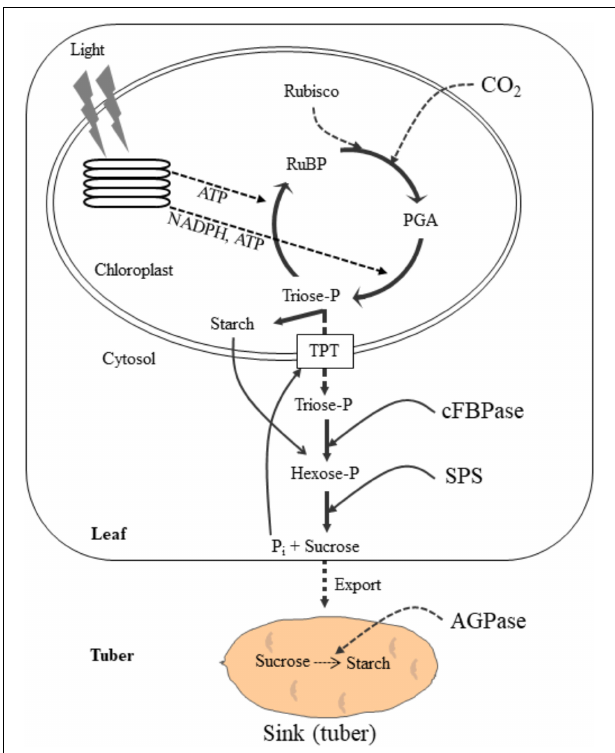
FIGURE 1 | A schematic diagram illustrating the photosynthetic carbon assimilation and its export to the potato tuber sink. In the chloroplast, light harvesting complexes absorb sunlight and generate ATP and NADPH through photosynthetic electron transport chain. The ATP and NADPH are then consumed by Calvin cycle to assimilate carbon to simple carbohydrate, triose phosphates (triose-P). Triose-P is either used to synthesize starch in the chloroplast or exported to cytosol in exchange for Pi through triose-P/P i translocator. In the cytosol, the triose-P is then converted to sucrose via hexose phosphates using key sucrose biosynthetic enzymes, cFBpase and SPS. Sucrose is then transported to the sink (tuber), where it is converted to starch by AGPase. The synthesis of sucrose in the cytosol generates P i which is exported to the chloroplast in the exchange for triose-P. Any stress that inhibit sucrose synthesis and its transport to sink (tuber) results in the feedback inhibition of photosynthesis due to P i regeneration limitation. The broken arrows indicate the stress sensitive processes. RuBisCO, ribulose-1,5-bisphosphate carboxylase/oxygenase; RuBP, ribulose-1,5-bisphosphate; TPT, triose phosphate translocator; cFBPase, cytosolic fructose bisphosphatase; SPS, sucrose phosphate synthase, AGPase: ADP glucose pyrophosphorylase. Modified from Hüner et al. (2016).